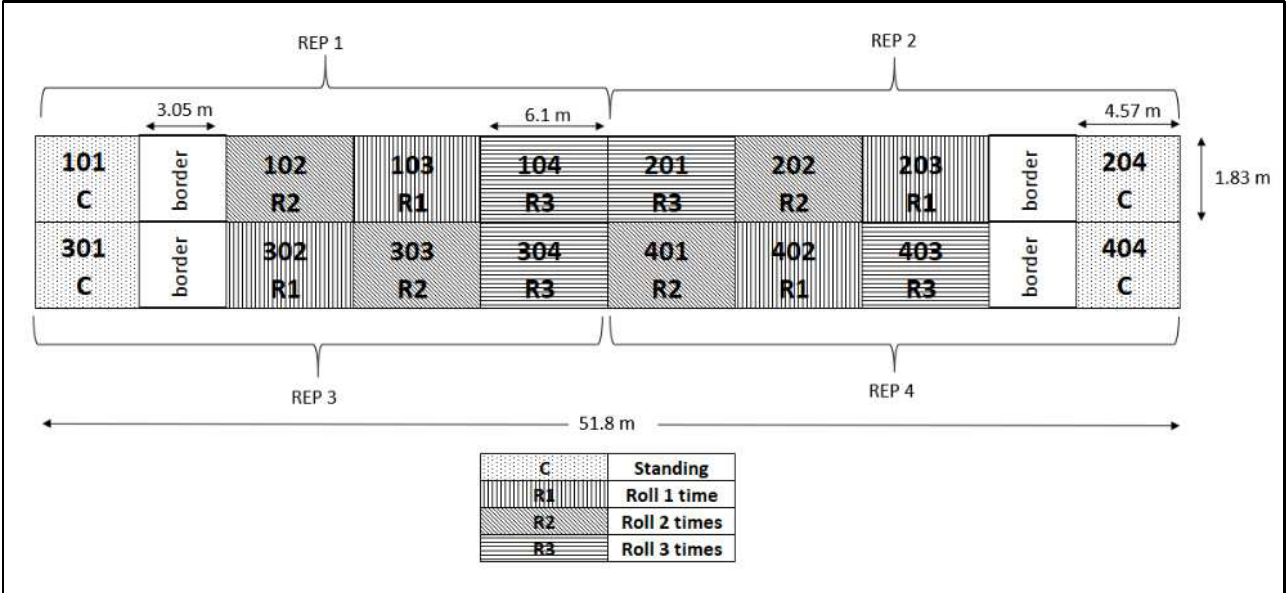
Figure 3. Experiment layout: the randomized block design with four replications.